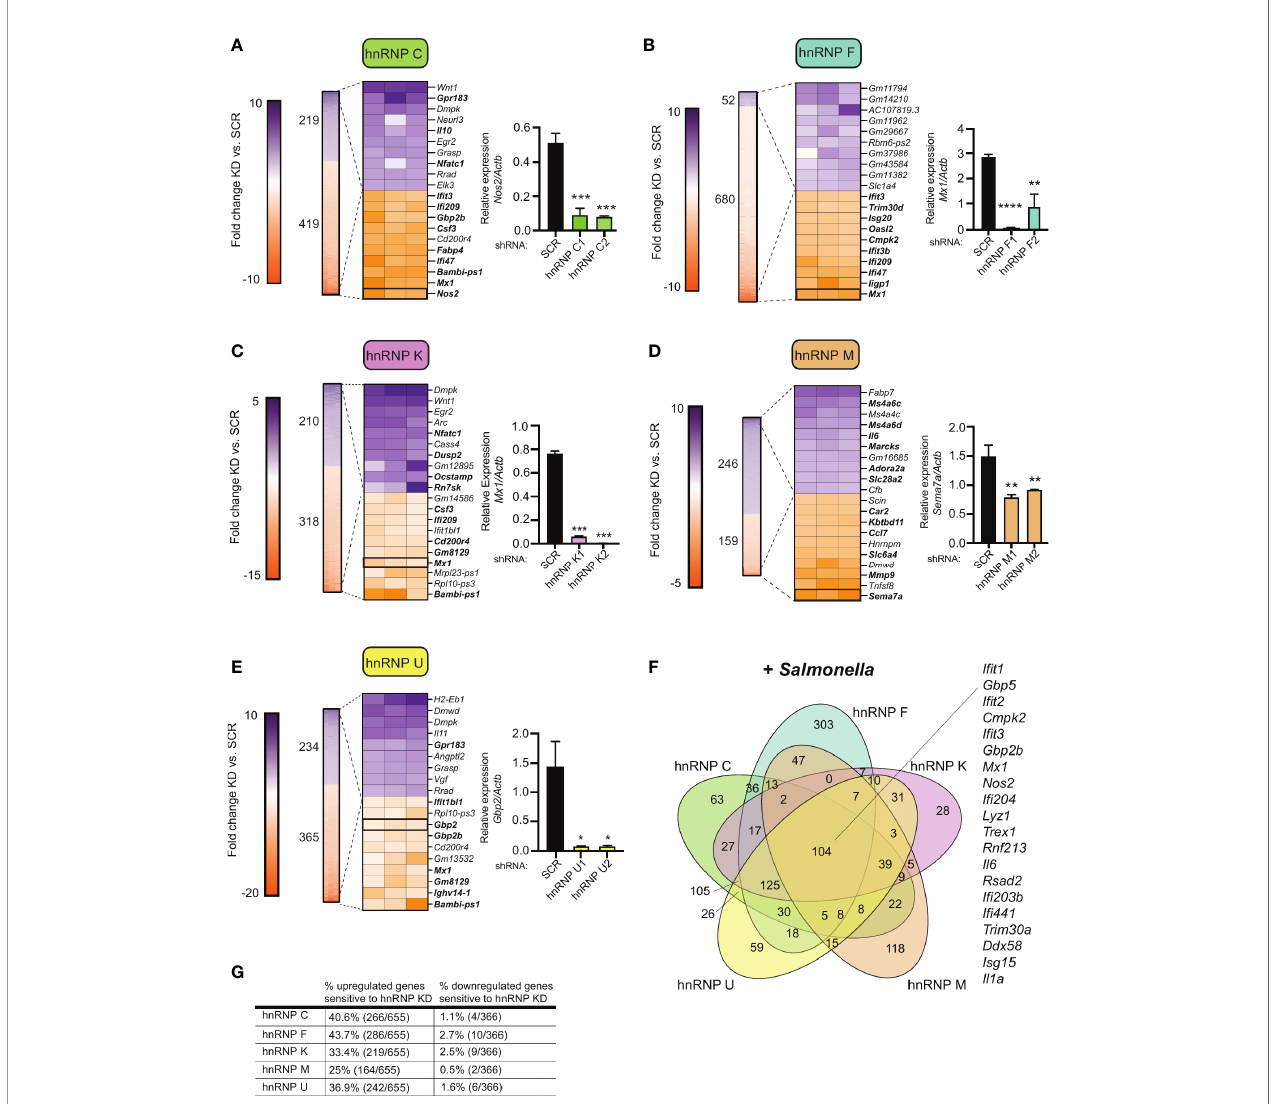
FIGURE 4 | Knockdown of hnRNP family members causes up- and down-regulation of gene expression in Salmonella -infected macrophages. (A) On left, heatmap represents all up- and down-regulated genes in hnRNP C knockdown macrophages relative to SCR control at 4h post- Salmonella infection (p<0.05). Numbers next to heatmap indicate the total number of up- (purple) or down- (orange) regulated genes in hnRNP C knockdown cell lines vs. SCR. Zoom in represents the top 10 up- and down-regulated genes. Genes whose expression is up- or down-regulated by virtue of Salmonella -infection itself (i.e. innate immune regulated genes) according to analysis of Salmonella -infected SCR vs. uninfected SCR cells are bolded. Box indicates gene chosen for RT-qPCR validation. On right, RT-qPCR validation of a representative DEG ( Nos2 ) in two knockdown cell lines vs. a SCR control (data shown relative to Actb ). (B) As in (A) but for hnRNP F; RT-qPCR of Mx1 . (C) As in (A) but for hnRNP K; RT-qPCR of Mx1 . (D) As in (A) but for hnRNP M; RT-qPCR of Sema7 ; (E) As in (A) but for hnRNP U; RT-qPCR of Gbp2 ; (F) Venn diagram of DEGs common to one or more hnRNP knockdown cell line (p<0.05). A subset of the 104 genes whose expression was impacted by loss of all fi ve hnRNP proteins are highlighted. (G) Percentage of all genes induced at 4h post- Salmonella infection (>2.0-fold) that are differentially expressed in each hnRNP knockdown macrophage cell line (p<0.05). For all RT-qPCRs values are the mean of 2 or 3 biological replicates and error bars indicate standard deviation. *p < 0.05; **p < 0.01; ***p < 0.001; ****p <